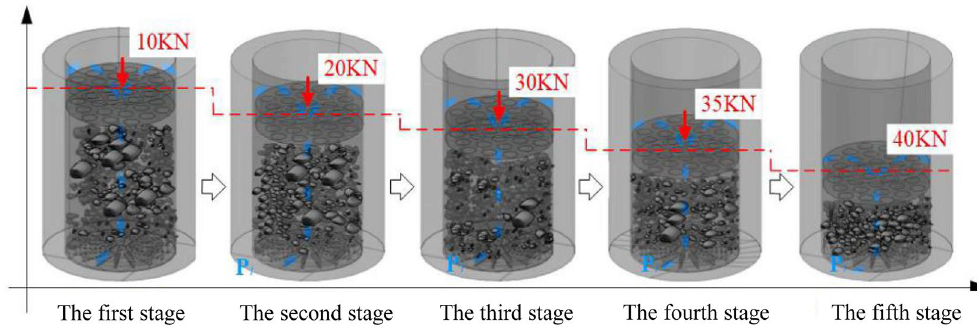
Figure 2. Pore permeability test process of the samples at the various load stages.